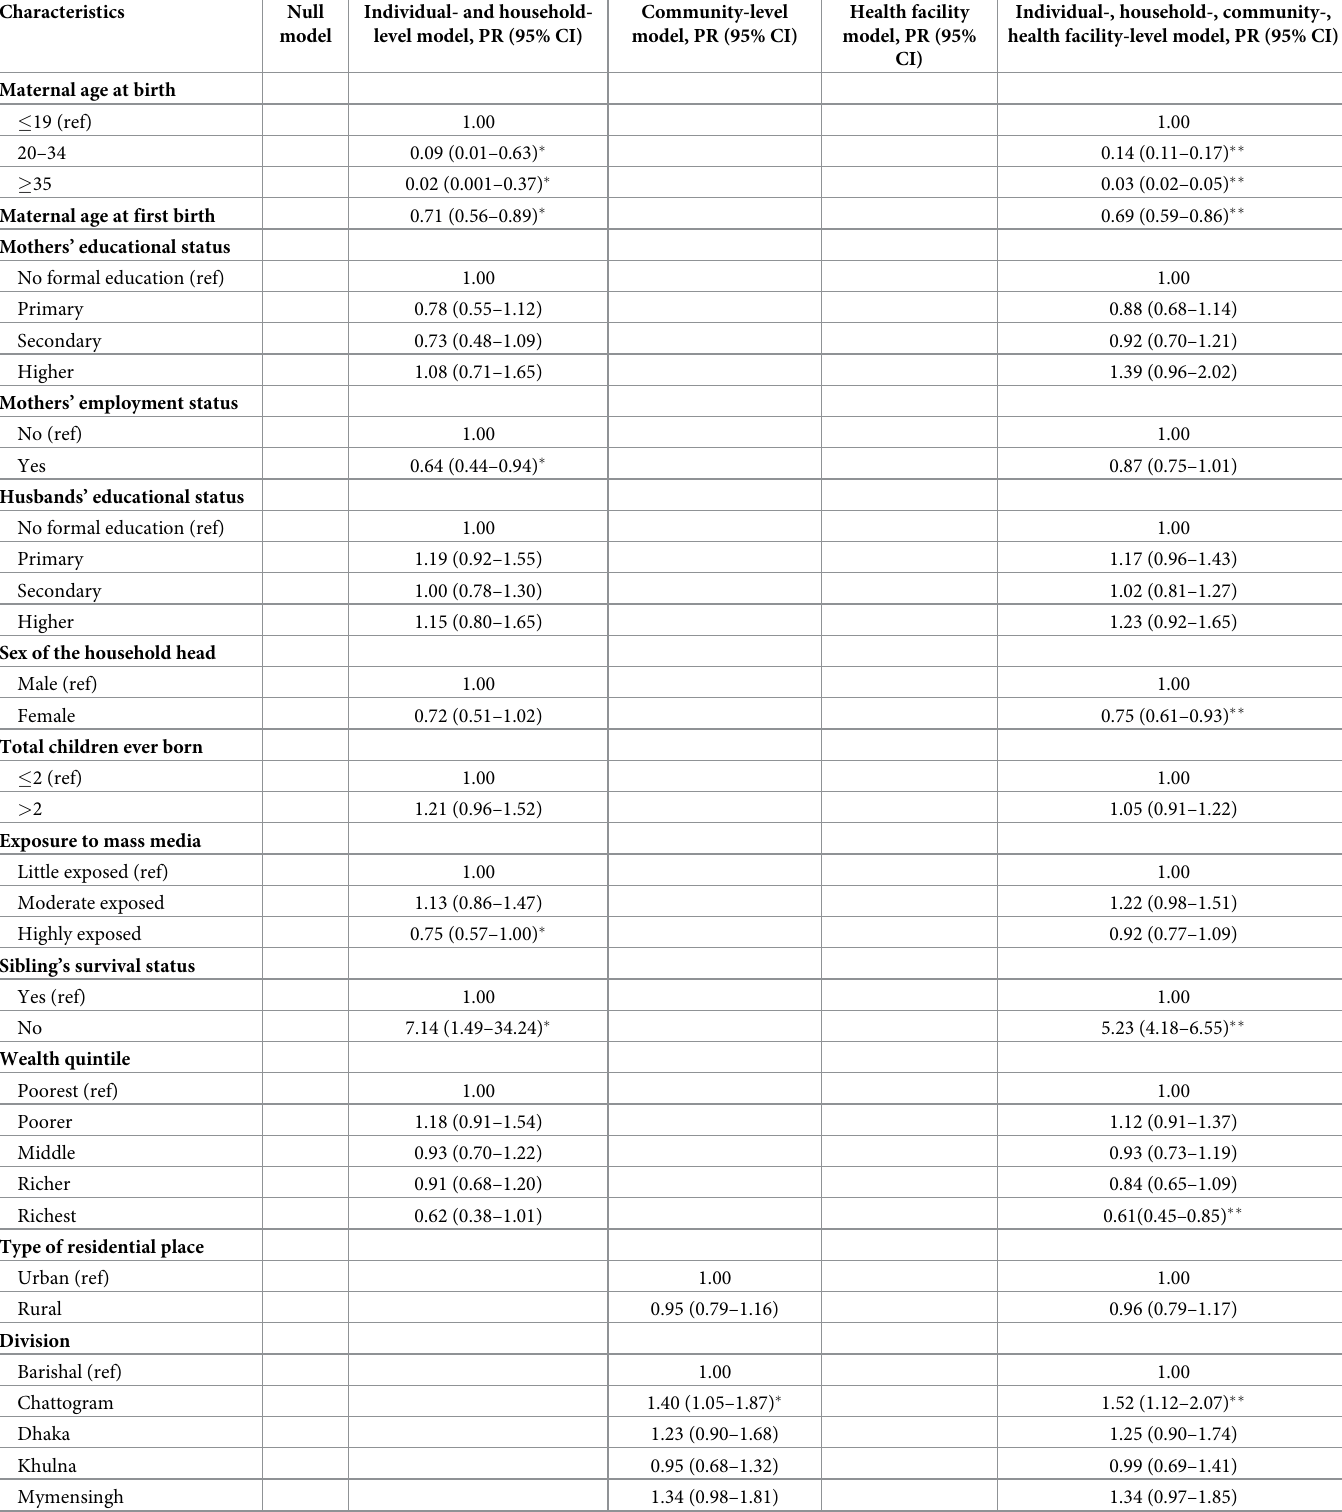
Table 4. Multilevel Poisson regression examining associated factors of short birth intervals in Bangladesh (n = 5,941).